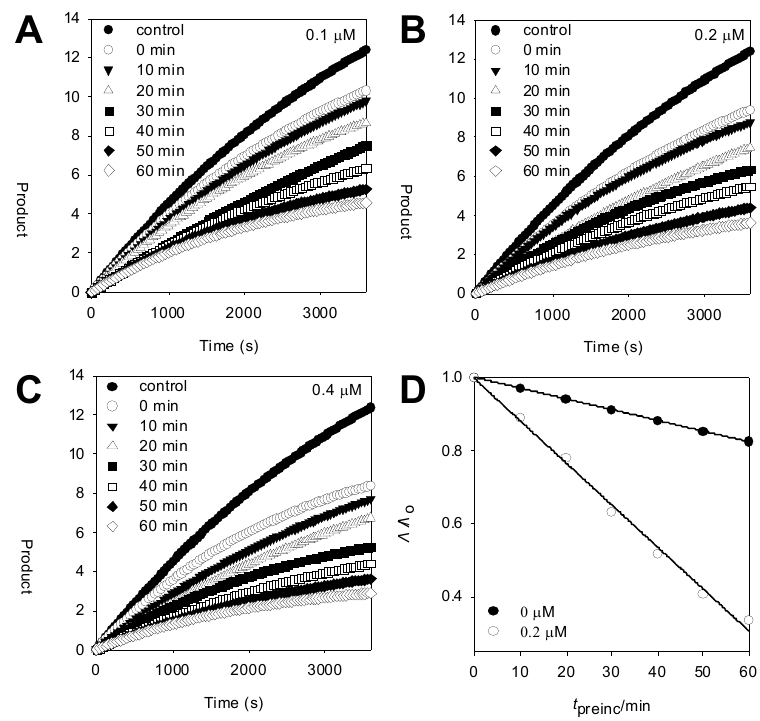
Figure 3. ( A – C ) Time-dependent inhibition of BACE1 in the presence of 0.1, 0.2, 0.4 μ M compound 5a ; ( D ) Decrease in slopes of the lines of panel E as a function of time ( ● , 0 μ M; ○ , 0.2 μ M).